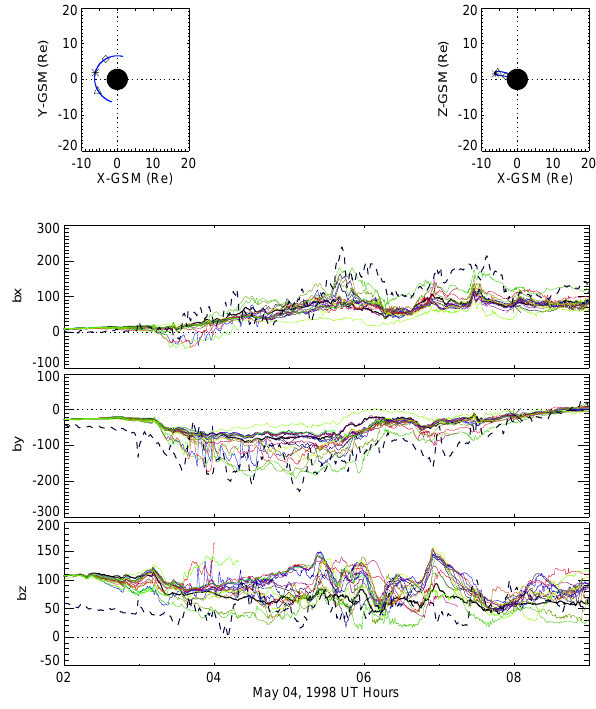
Fig. 16. Comparison with the GOES-09 satellite in the same format as Fig.